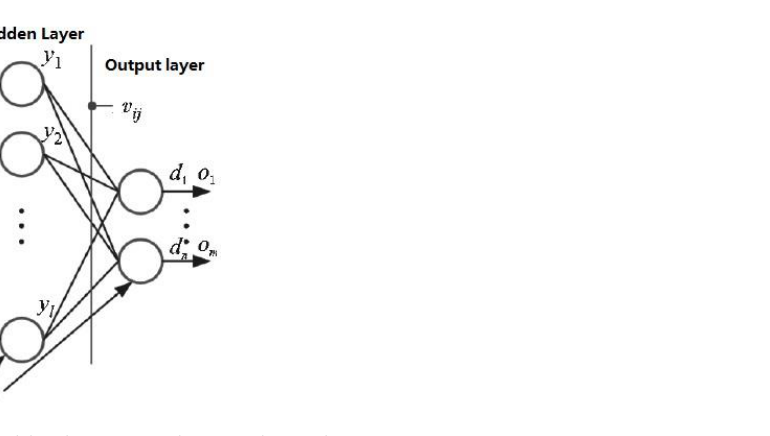
Figure 8. Single hidden layer neural network topology. The fitting residual (RE), sum of squares of the error (SSE) and mean absolute error (MAE) are shown in Equations (28) to (30).